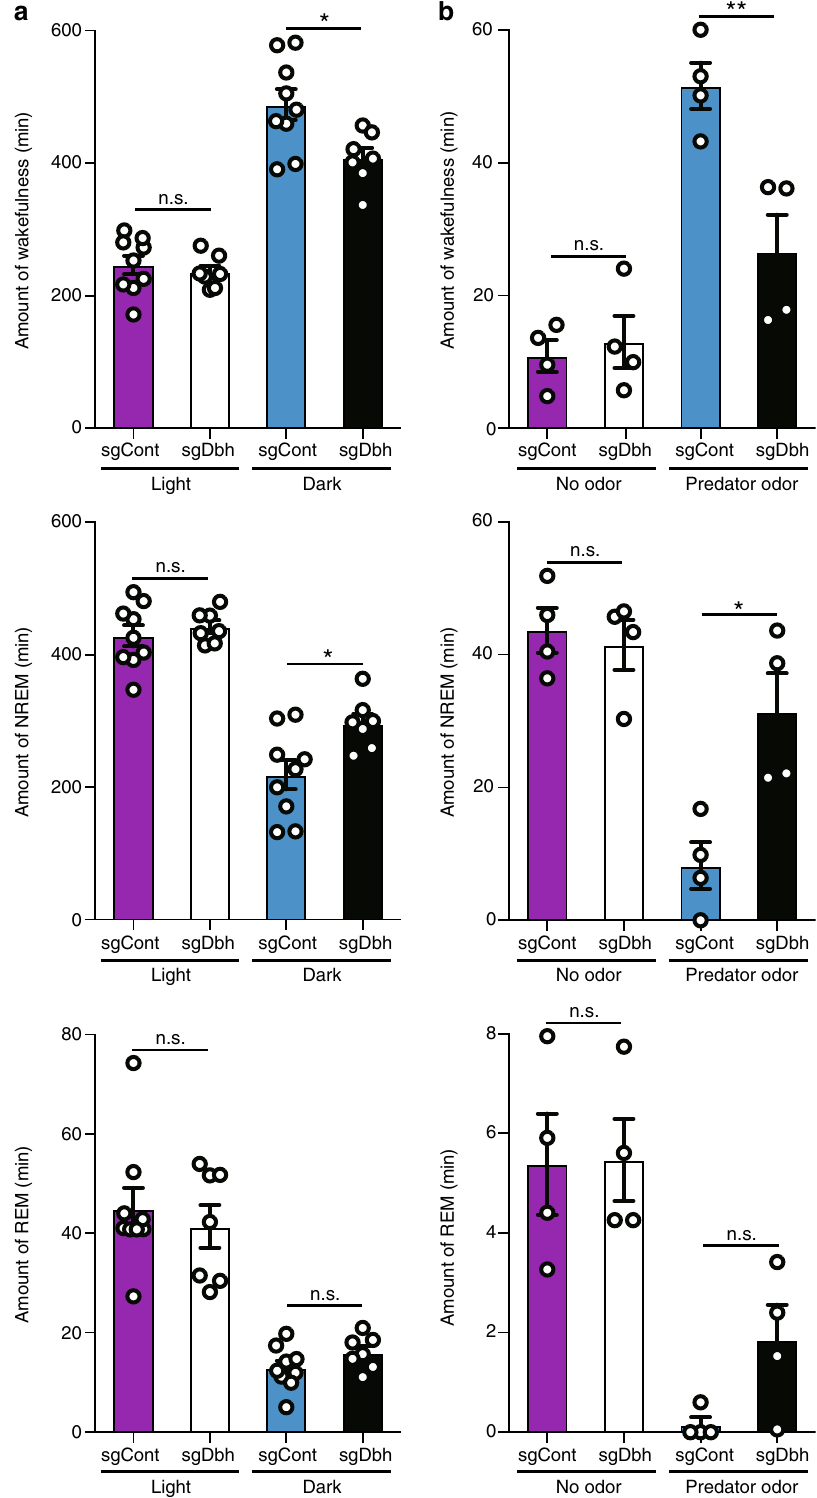
Fig. 4 Chronic effect of bilateral LC-speci fi c dbh disruption on sleep-wake cycle. a Total amount of wakefulness (top), NREM (middle), and REM (bottom) sleep during the light or dark phases (* P < 0.05; n.s., not signi fi cant by two-tailed Student t -test between sgControl ( n = 9) and sgDbh ( n = 7); t = 2.73 (wakefulness) and 2.76 (NREM), d f = 14 (wakefulness) and 14 (NREM)). b Total amount of wakefulness (top), NREM (middle), and REM (bottom) sleep in the presence of predator odor during the 1-h test period (* P < 0.05, ** P < 0.01; n.s., not signi fi cant by two-tailed Student t -test between sgControl ( n = 4) and sgDbh ( n = 4); t = 3.814 (wakefulness), 3.481 (NREM), and 2.342 (REM), d f = 6 (wakefulness), 6 (NREM), and 6